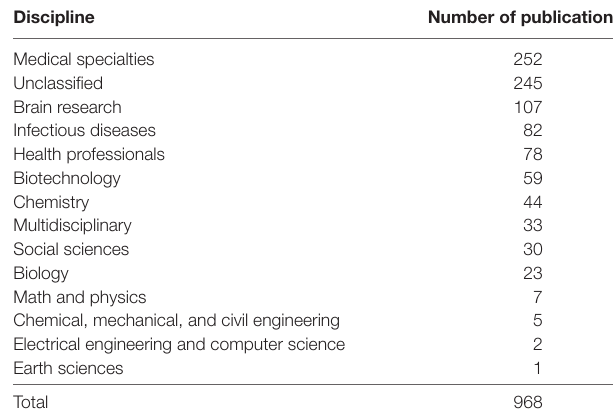
Table 4 | Number of publication per discipline associated with the NIH and NSF